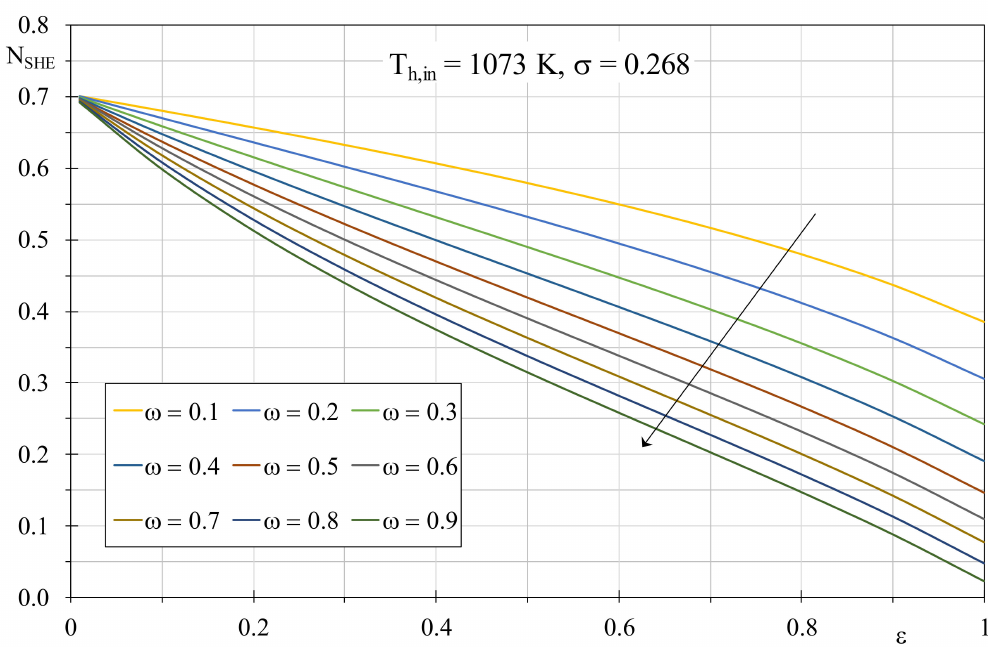
Figure 3. EGN for an unbalanced heat exchanger operating in counter-current related to the efficiency, the thermal capacity ratio, by setting cold and hot fluid inlet temperatures of 288 K and 1073 K, respectively, and the maximum thermal capacity for the cold